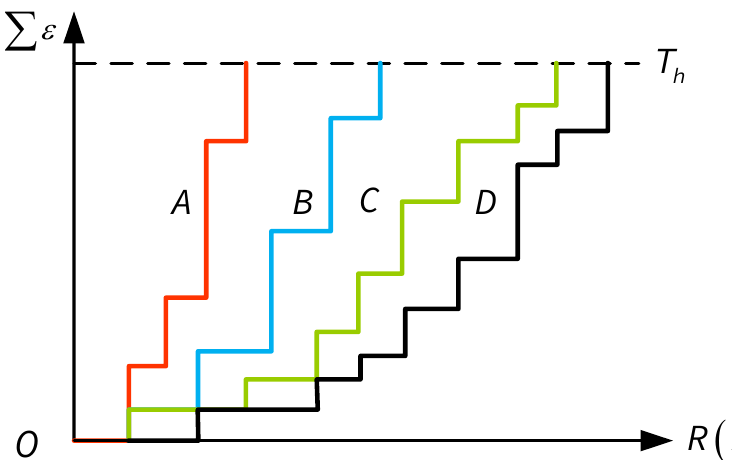
Figure 11. SSDA algorithm matching chart.